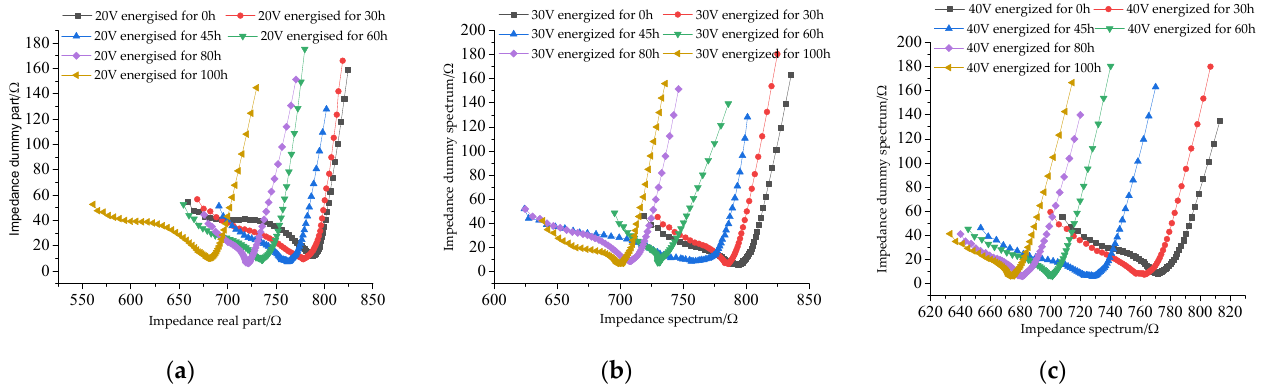
Figure 6. Concrete resistivity. ( a ) C30-14-20 AC impedance spectrum; ( b ) C30-14-30 AC impedance spectrum; ( c ) C30-14-40 AC impedance spectrum.